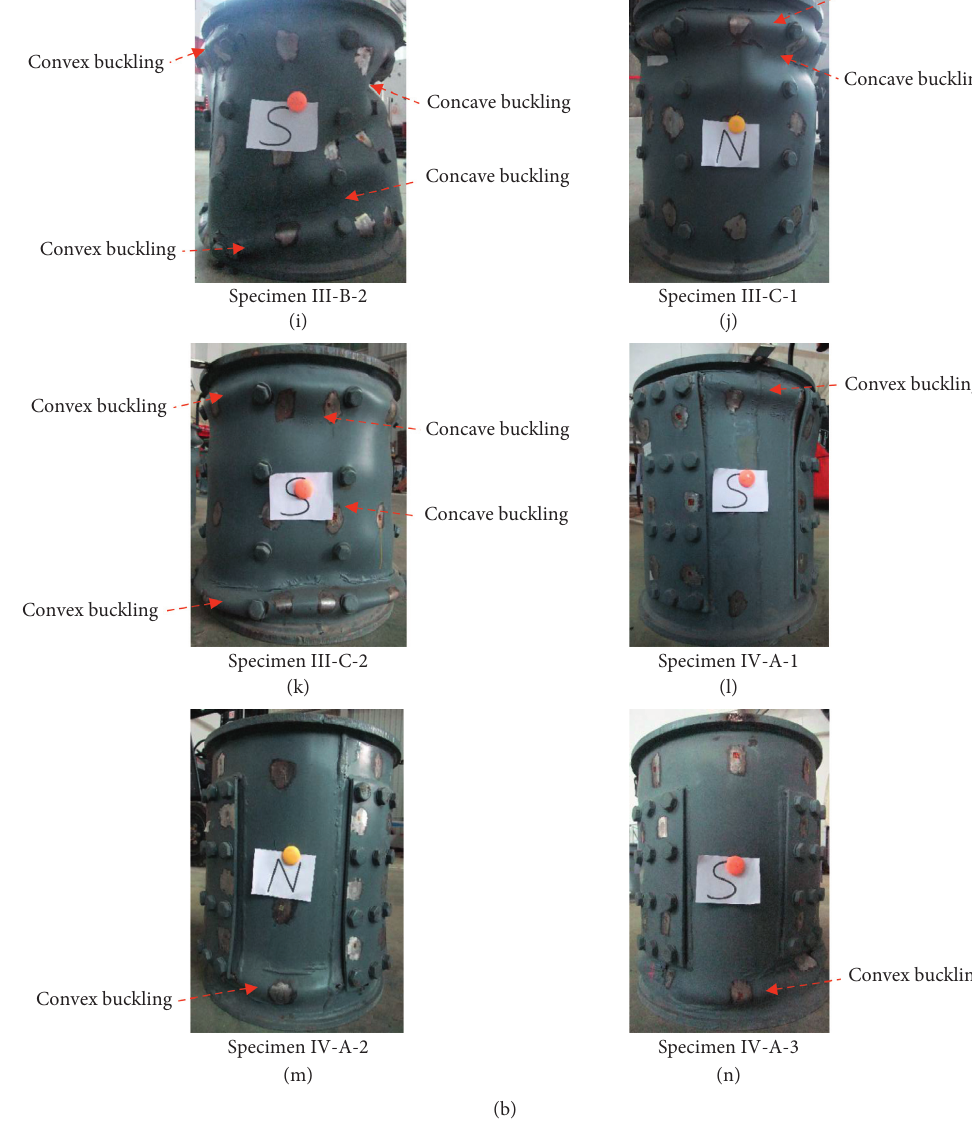
Figure 7: Failure mode of new tubular steel piers under axial compression. (a) Specimen I-0. (b) Specimen I-A. (c) Specimen II-A-1. (d) Specimen II-A-2. (e) Specimen II-A-3. (f) Specimen III-A-1. (g) Specimen III-A-2. (h) Specimen III-B-1. (i) Specimen III-B-2. (j) Specimen III-C-1. (k) Specimen III-C-2. (l) Specimen IV-A-1. (m) Specimen IV-A-2. (n) Specimen